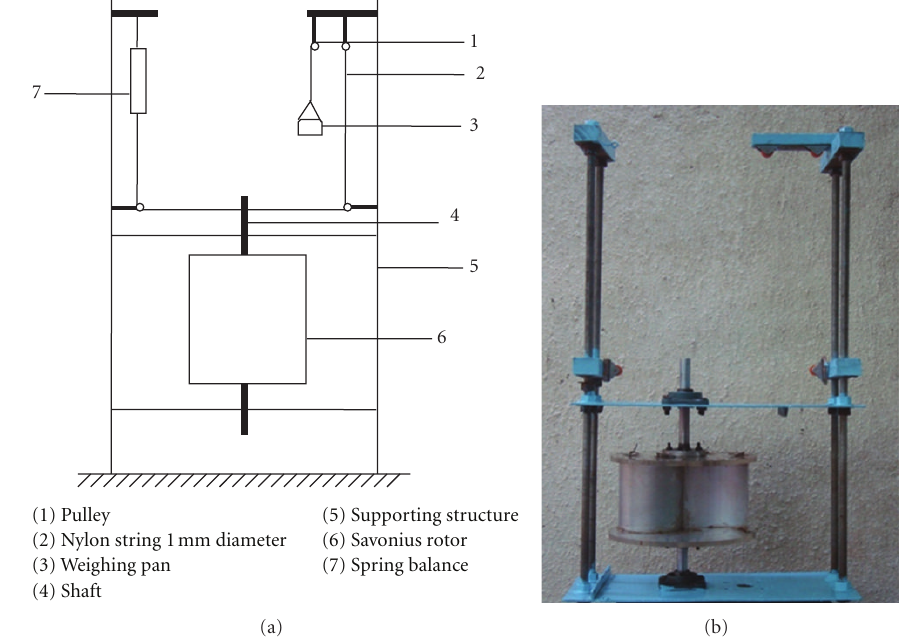
Figure 2: (a) Schematic diagram of the test setup for modified Savonius rotor, (b) pictorial representation of test setup for modified Savonius